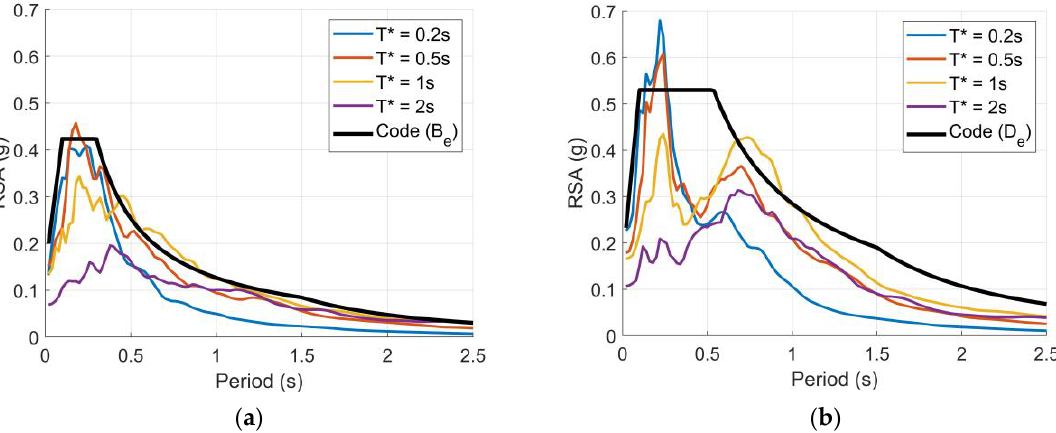
Figure 3. Individual and mean site-specific velocity response spectra for the four reference periods: ( a ) site-specific 1 (T* = 0.2 s), ( b ) site-specific 2 (T* = 0.5 s), ( c ) site-specific 3 (T* = 1 s), and ( d ) site- specific 4 (T* = 2 s).